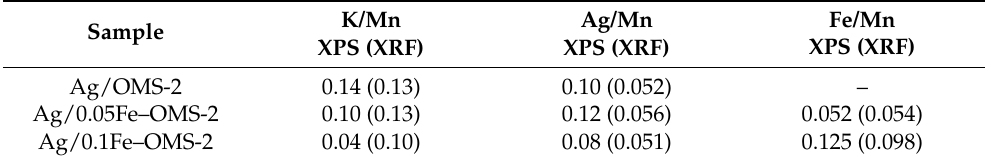
Table 2. Surface composition (XPS) and elemental composition (XRF) for the prepared samples.